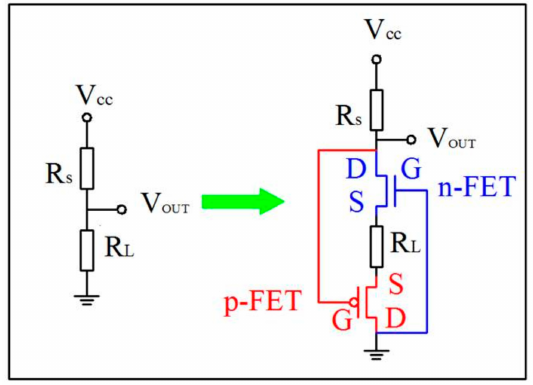
Figure 1. Design scheme of the traditional circuit and the interlocking p+n field effect transistor (FET) circuit for metal oxide (MOX) acetone